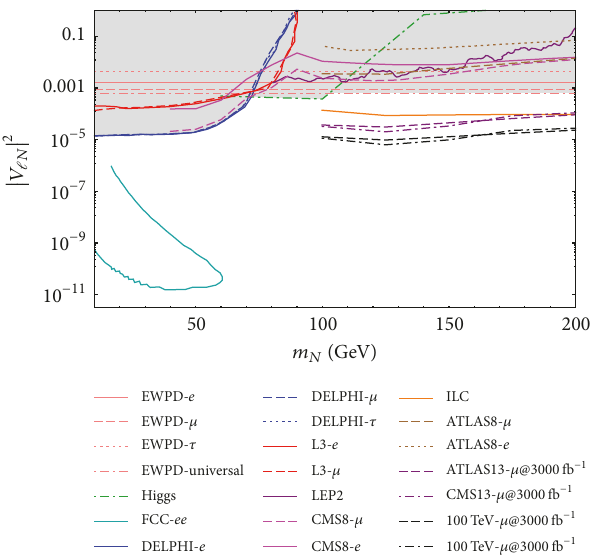
red dashed line stands for the exclusion limits coming from 𝜇 (L3- 𝜇 ). The corresponding exclusion limits on |𝑉 (ℓ=𝑒)𝑁 | at the 95 % CL [22, 23] have been drawn from the LEP2 data which have been denoted by the dark magenta line. In this analysis they searched for 80 GeV ≤ 𝑀 𝑁 ≤ 205 GeV with a center of mass energy between 130 GeV and 208 GeV